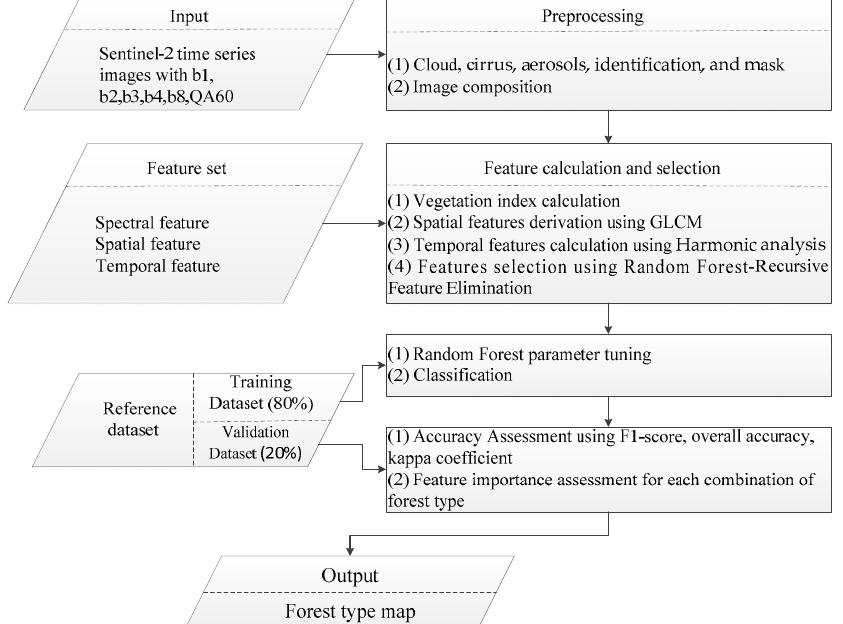
Figure 2. Methodological workflow of the study.